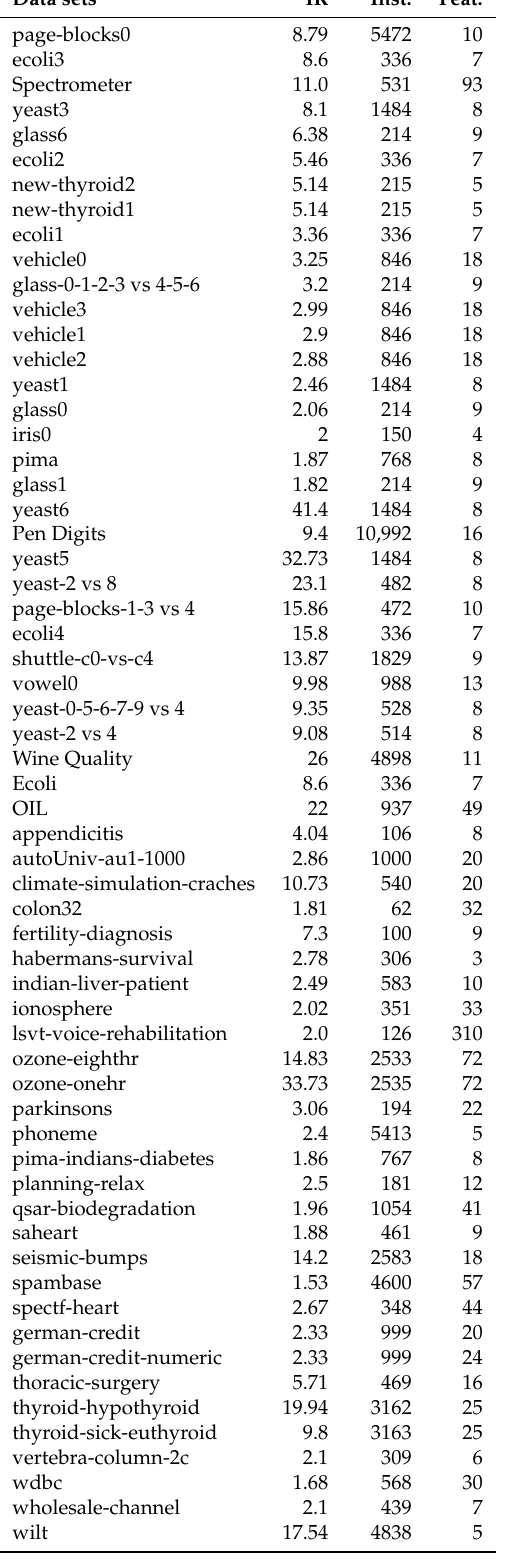
Table 4. Bi-class data